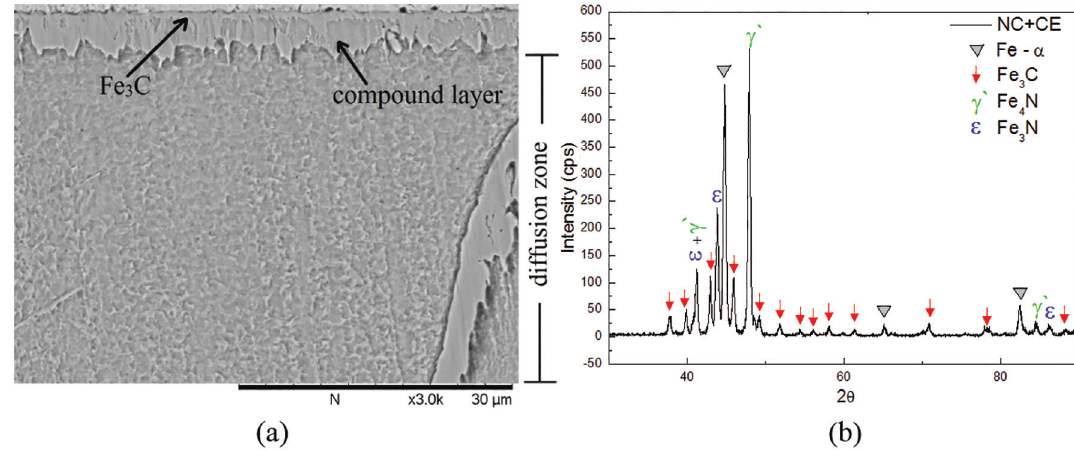
Figure 7: Sample NC+CE: (a) scanning electron microscopy and (b) XRD.